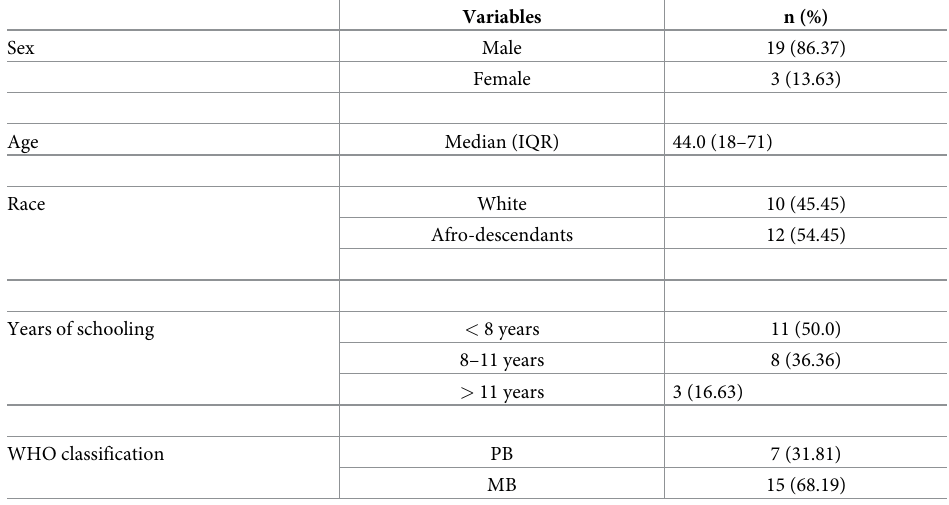
Table 1. Demographic and clinical characteristics of 22 leprosy patients and neural involvement